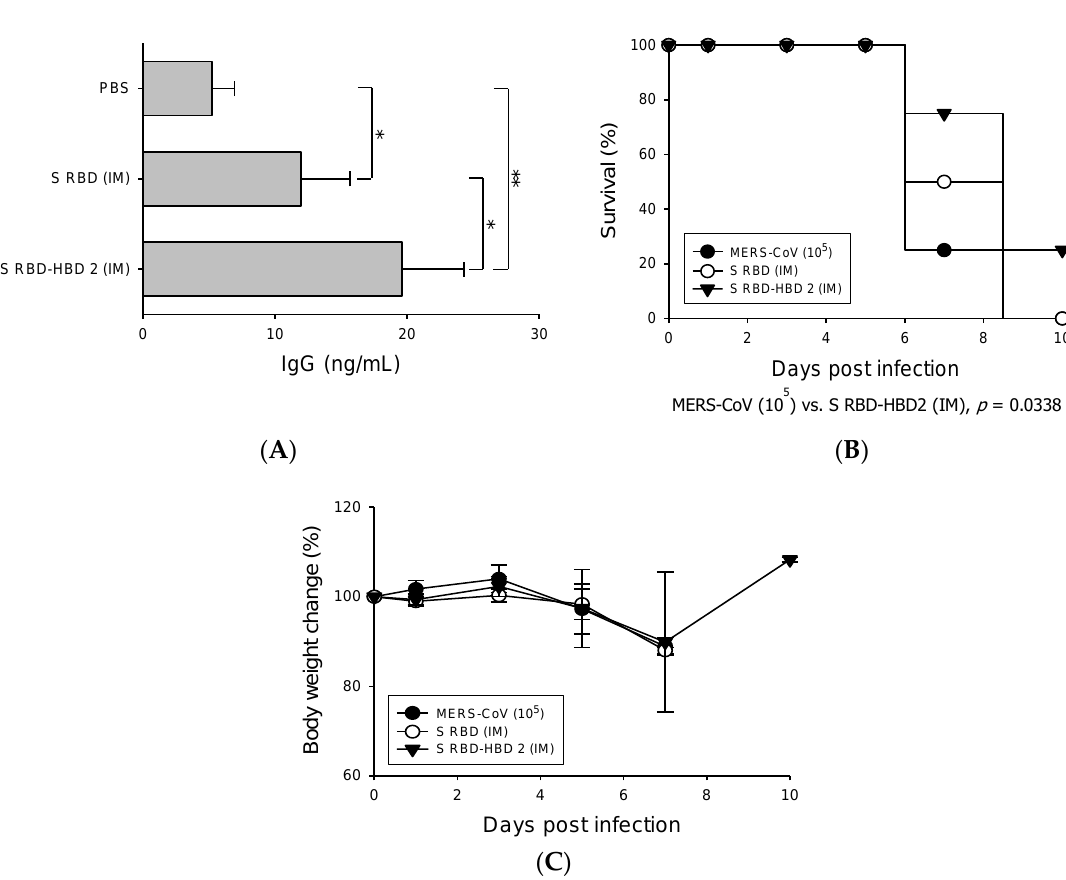
Figure 2. Immunization with S RBD-HBD 2 elicits potent Ag-specific immunity and reduces mortality upon MERS-CoV infection in hDPP4-Tg mice. Mice were intramuscularly (IM) immunized with 5 µ g / mouse of S RBD with or without HBD 2, and sera were collected three days after boost immunization. The levels of S RBD-specific IgG were measured using enzyme-linked immunosorbent assay (ELISA). Data are presented as means ± SDs ( n = 3). Immunized mice were challenged intranasally (IN) with MERS-CoV (10 5 PFU). Infected mice were monitored every other day for weight loss, clinical symptoms, and survival. ( A ) Serum levels of S RBD-specific IgG which were determined via capture ELISA using standard mouse IgG. * p < 0.05 and ** p < 0.01. ( B ) Survival of hDPP4-Tg mice after MERS-CoV infection ( n = 8). P -values were calculated using the log-rank (Mantel–Cox) test. ( C ) Bodyweight changes in MERS-CoV-infected mice. Results are presented as means ± SDs ( n = 8) at the indicated times post-infection. There is no statistical significance in body weight changes among the groups tested.